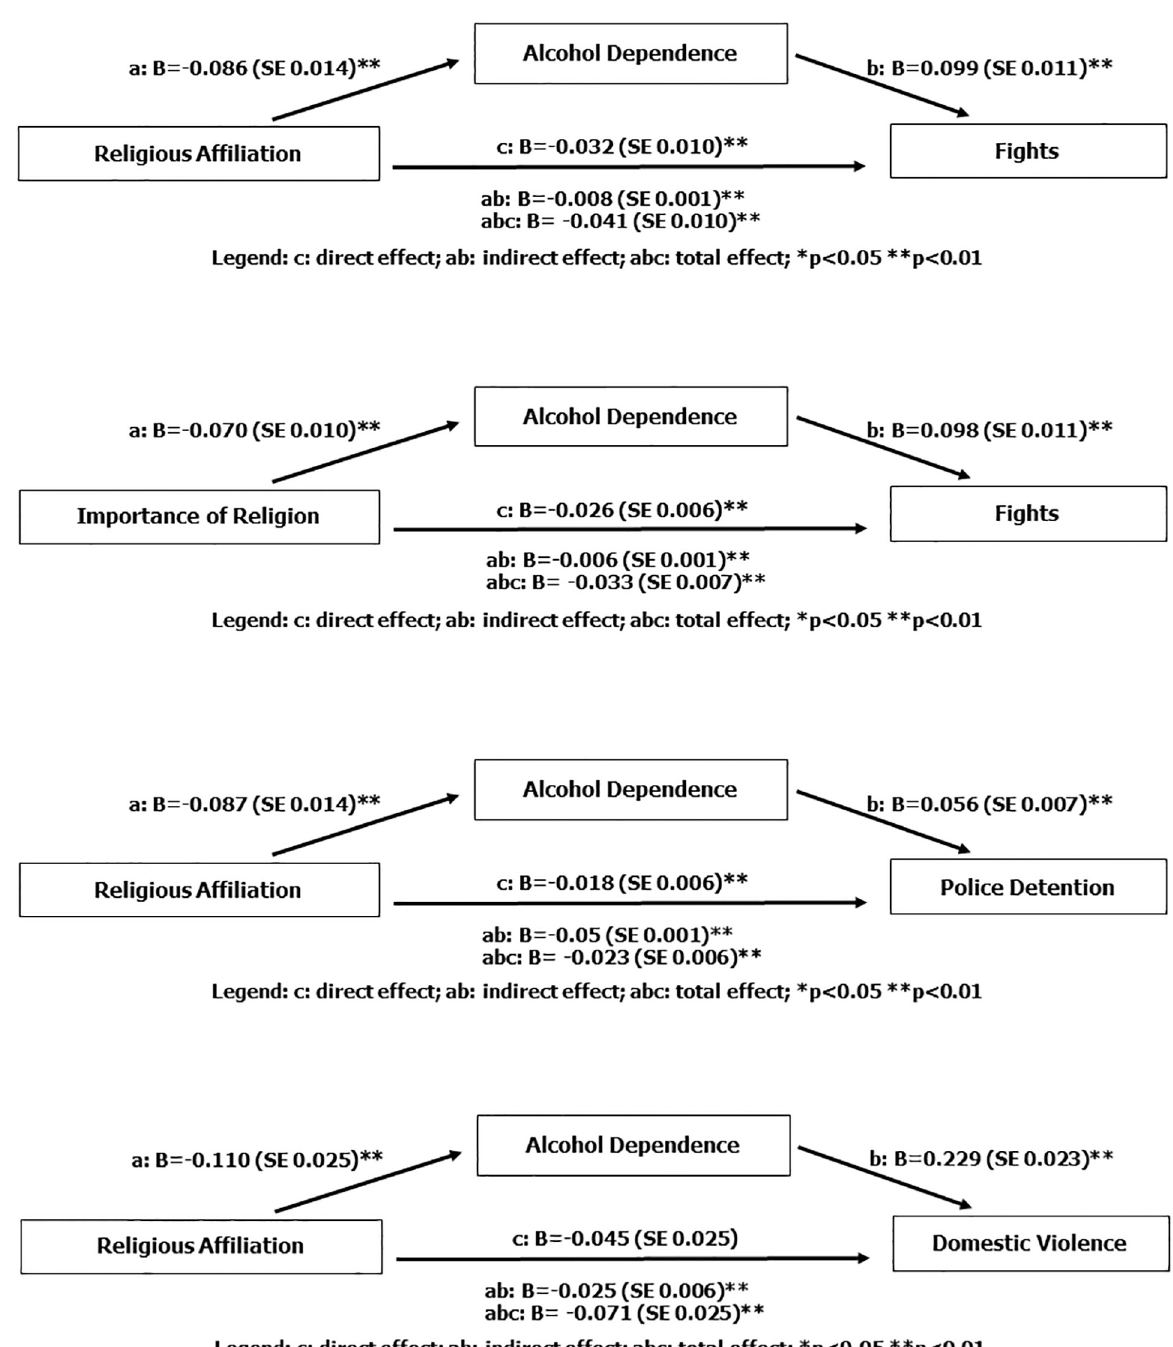
Fig 1. Alcohol dependence as a mediator: Indirect effect of religiosity on